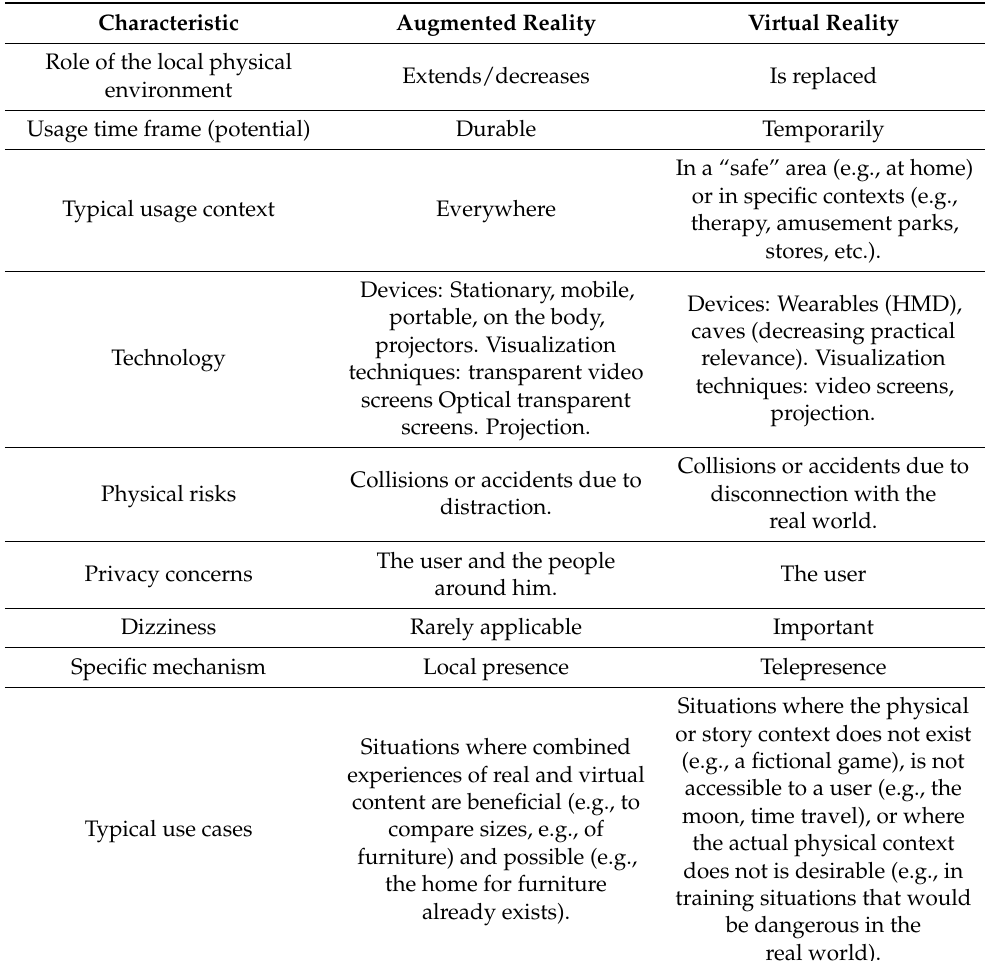
Table 1. Differences between AR and